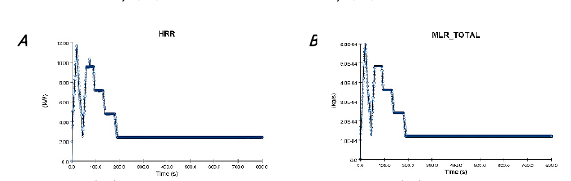
Figure 9. (A) the max HRR=11.9 kW and (B) the max rate of volumetric release of total fuel per unit time = 0.0006 kg⁄s at